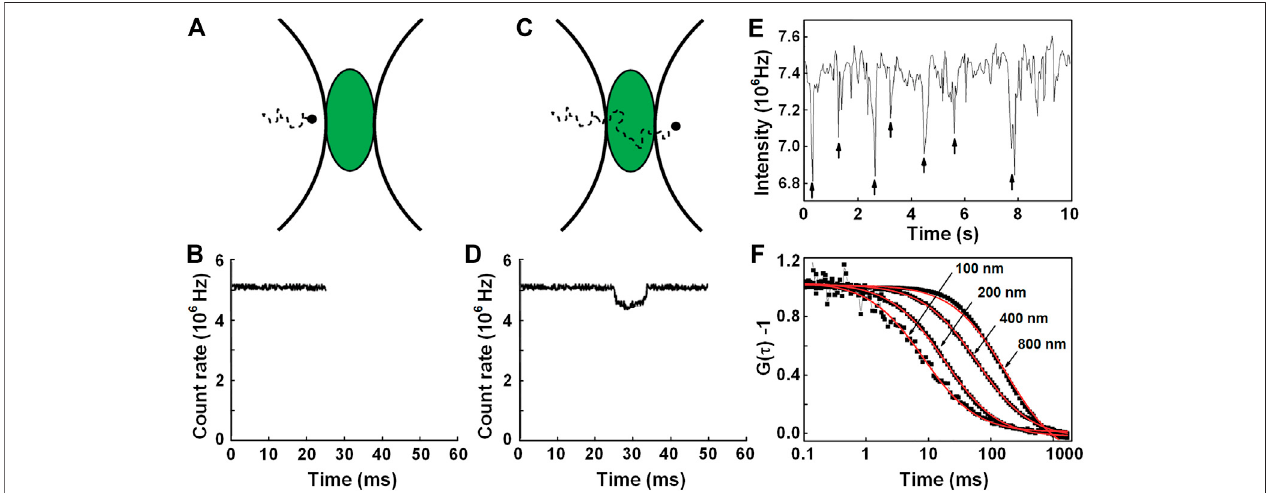
FIGURE 10 | Principle illustration of iFCS. ( A ) ∼ ( D ) A fl uorescence signal is reduced upon the entrance of a non- fl uorescent particle into the detection volume. ( E ) Intensity trace caused by the diffusion of 400-nm beads in 400- μ M Alexa 488-medium. ( F ) Normalized iFCS curves from the diffusion of 100, 200, 400, and 800 nm beads in 400 μ M Alexa 488. Adapted from Ref.